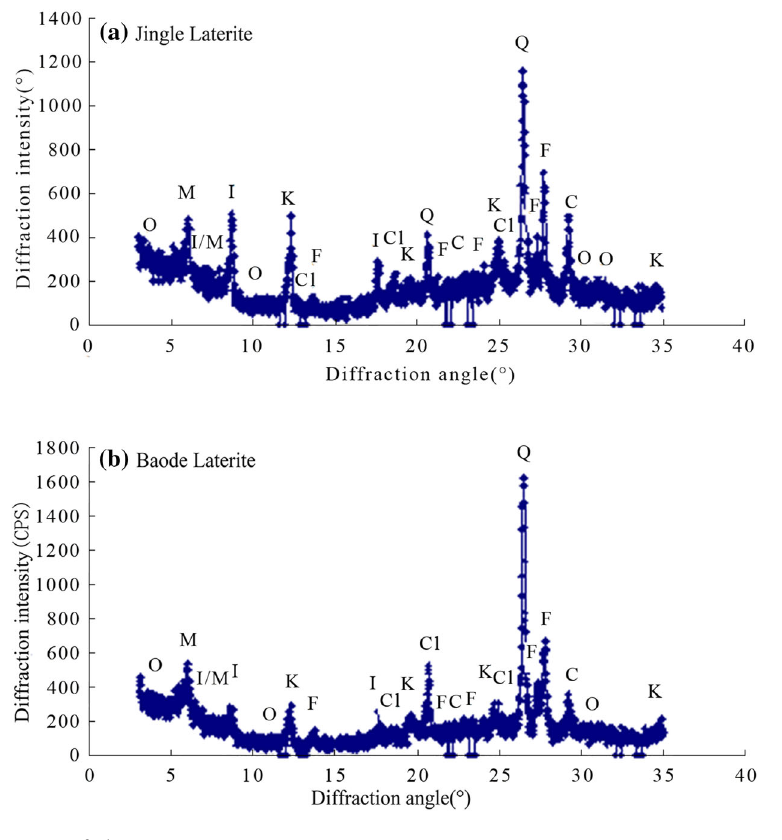
Fig. 4 X-ray diffraction spectrum of clay Table 1 Relative quantitative analysis results of clay